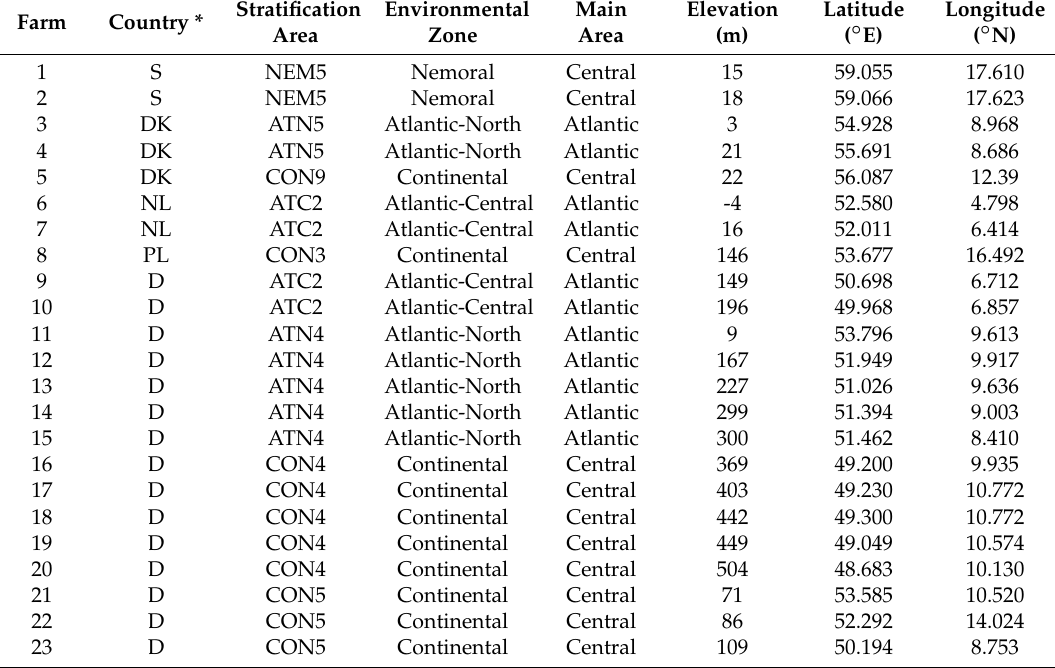
Table 1. Farm number, country, stratification area, and environmental zone according to Reference [12], followed by the clustering of the environmental zones into three main areas; farm position based on elevation, latitude, and